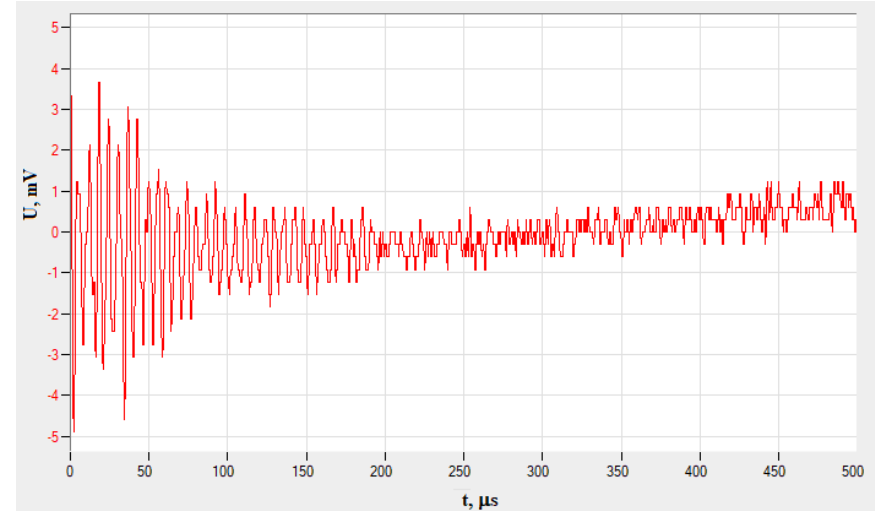
Figure 5. An example of an AE signal recorded during tensile test of Sample No. 3 (PAC system).